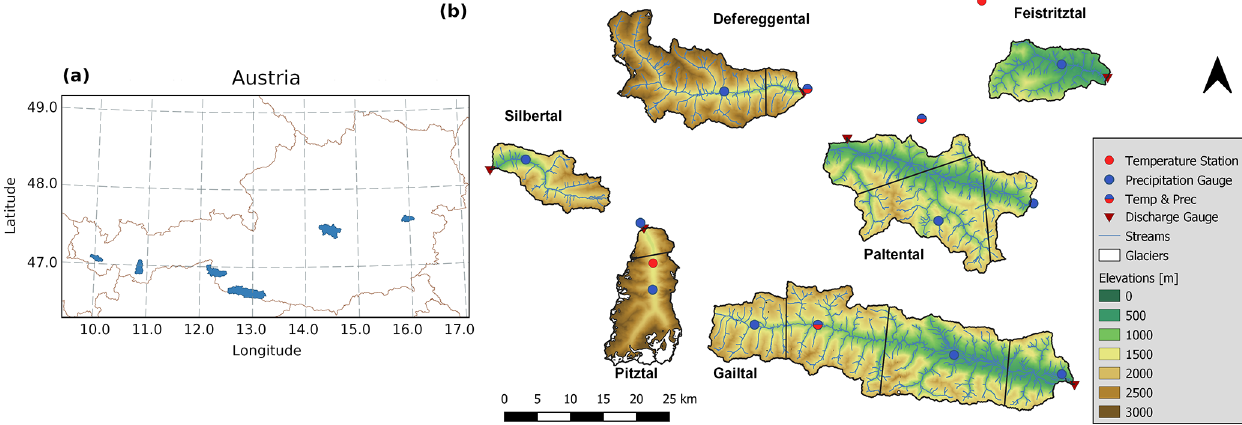
Figure 1. (a) Location of the six study catchments in Austria (shaded blue area). (b) Elevation maps of the study catchments, including the location of precipitation and temperature observation stations, as well as the division into precipitation zones (black lines). Table 1. Catchment characteristics. Precipitation and temperature are based on data from 1986–2010 used in this study. Runoff coefficients are based on simulations of this study. The runoff regimes are based on Mader et al. (1996).